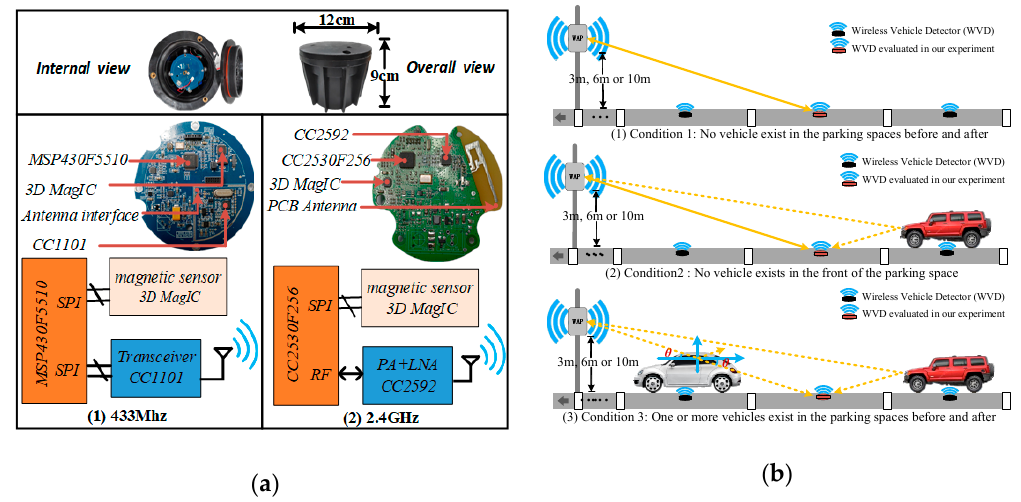
Figure 3. The hardware setups and different evaluation scenarios. ( a ) The hardware implementation of two types of wireless vehicle detector prototypes; ( b ) Three different evaluation and verification